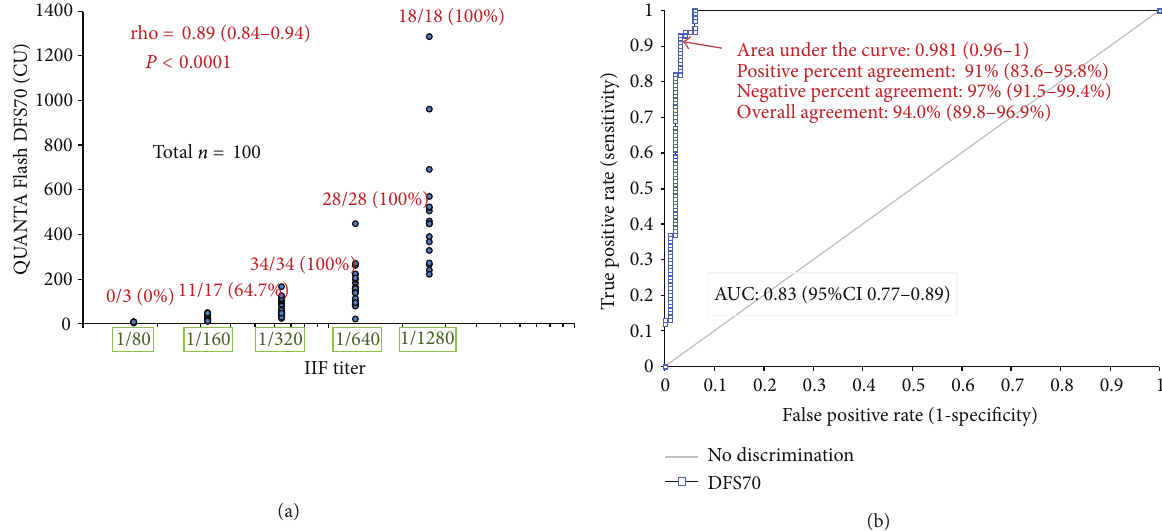
F 1: Correlation between dense �ne speckled (DFS) pattern by indirect immuno�uorescence (IIF) and anti-DFS70 antibodies measured by chemiluminescent immunoassay (CIA). (a) Correlation between the anti-DFS antibody titer by IIF and by QUANTA Flash DFS70. Excellent correlation between the anti-DFS antibody titers by IIF and by QUANTA Flash DFS70 was found using the samples showing the DFS speckled pattern ( ). Number and percent of the anti-DFS70 antibody positive samples are shown per titer group (cut-off = 20 CU). (b) Receiver operating characteristics (ROC) analysis comparing samples with DFS ( ) and other IIF ANA patterns ( ) by means of anti-DFS70 antibodies. Excellent discrimination between samples with DFS pattern and other patterns was observed as underlined 𝑛𝑛 𝑛 𝑛𝑛𝑛 by an area under the curve value of 0.981 (95 𝑛𝑛 𝑛 𝑛𝑛𝑛 𝑛𝑛 𝑛 𝑛𝑛𝑛